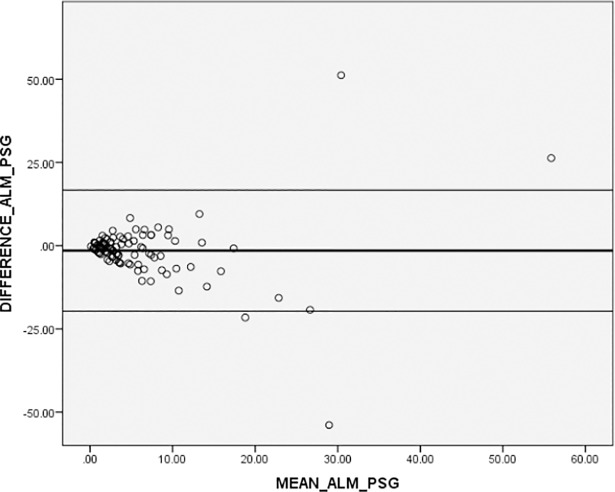
Bland-Altman plot illustrating the difference in AHI as measured from ApneaLinkTM manually revised versus PSG.Plots present differences between the two methods compared to mean AHI of the two methods. The black solid line represents the mean difference, the black thin lines the 95% confidence intervals on the limits of agreement. ALM, ApneaLinkTM manually revised; PSG, polysomnography.